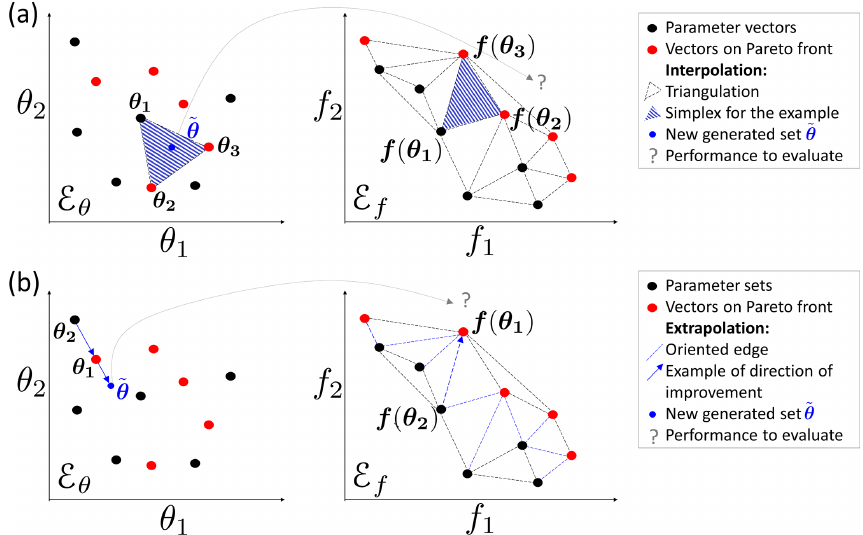
Figure 3. Illustration of rules 1 and 2 based on a Delaunay triangulation in the objective space for a maximization problem with two parameters ( θ 1 and θ 2 ) and two objectives ( f 1 and f 2 ): (a) interpolation computes a new parameter vector for each simplex with a non- dominated vertex; (b) extrapolation derives a new vector for each direction of